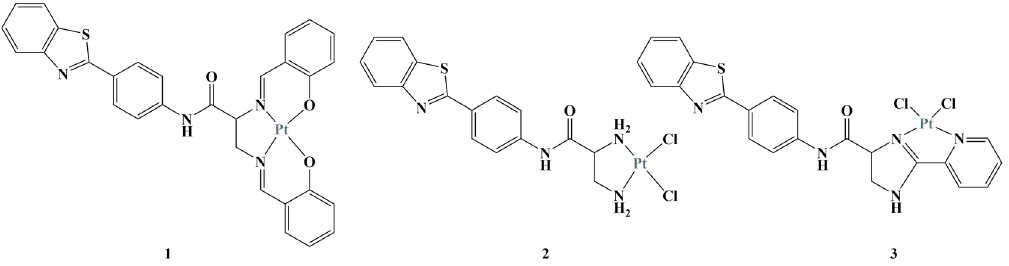
Figure 7. The complexes described in [32].